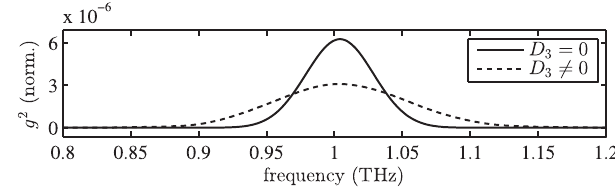
FIG. 4. Narrowband form factors resulting from start-to-end simulations with and without third-order dispersion D 3 (see text for details).